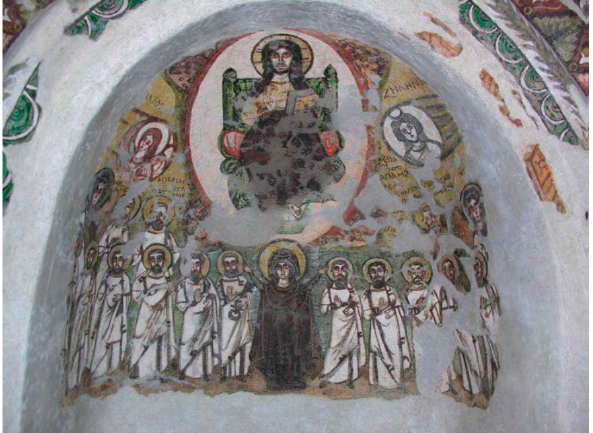
Figure 15. Cairo, Coptic Museum: wall paintings of chapel 6 of Bawit (Egypt). 6th century. © Coptic Museum (with kind permission).